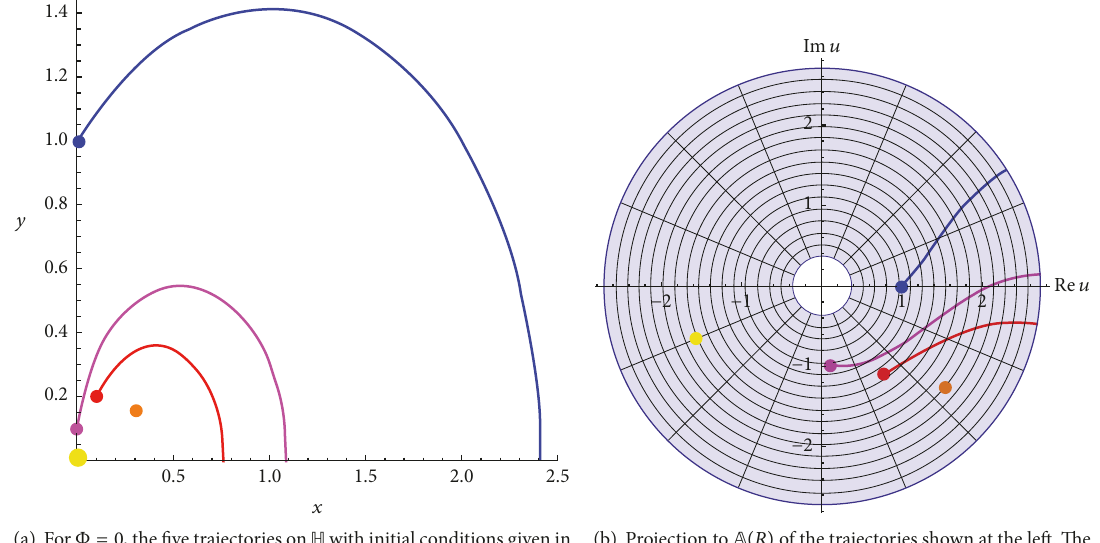
Figure 17: The lifted potentials